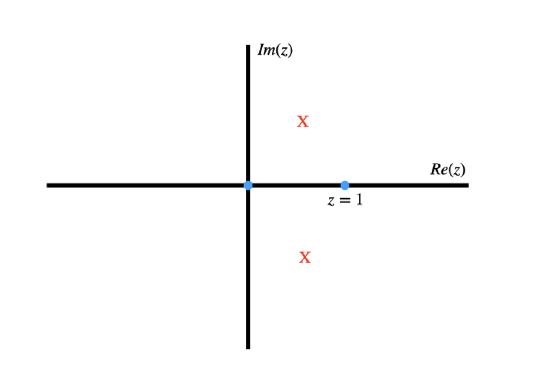
Figure 2. The analytic structure for each spin- J partial wave. The blue circles are potential singularities at z = 0 , 1 while the red crosses are potential singularities at z 2 − z + 1 = 0